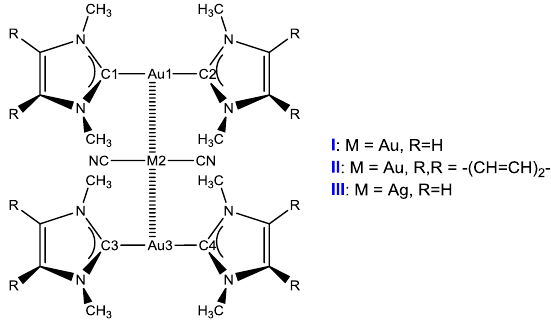
Figure 1. Schematic structure of metallophilic host clusters X ( X = I, II, and III).